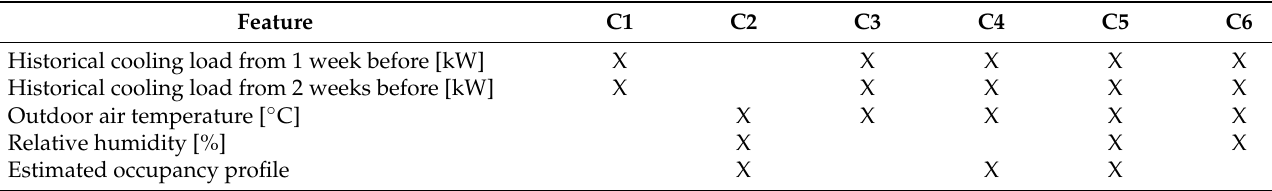
Table 1. Sets of features tested for cooling energy demand